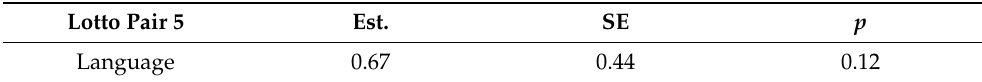
Table 11. Percentage of “A” choices in the Lotto task by language.